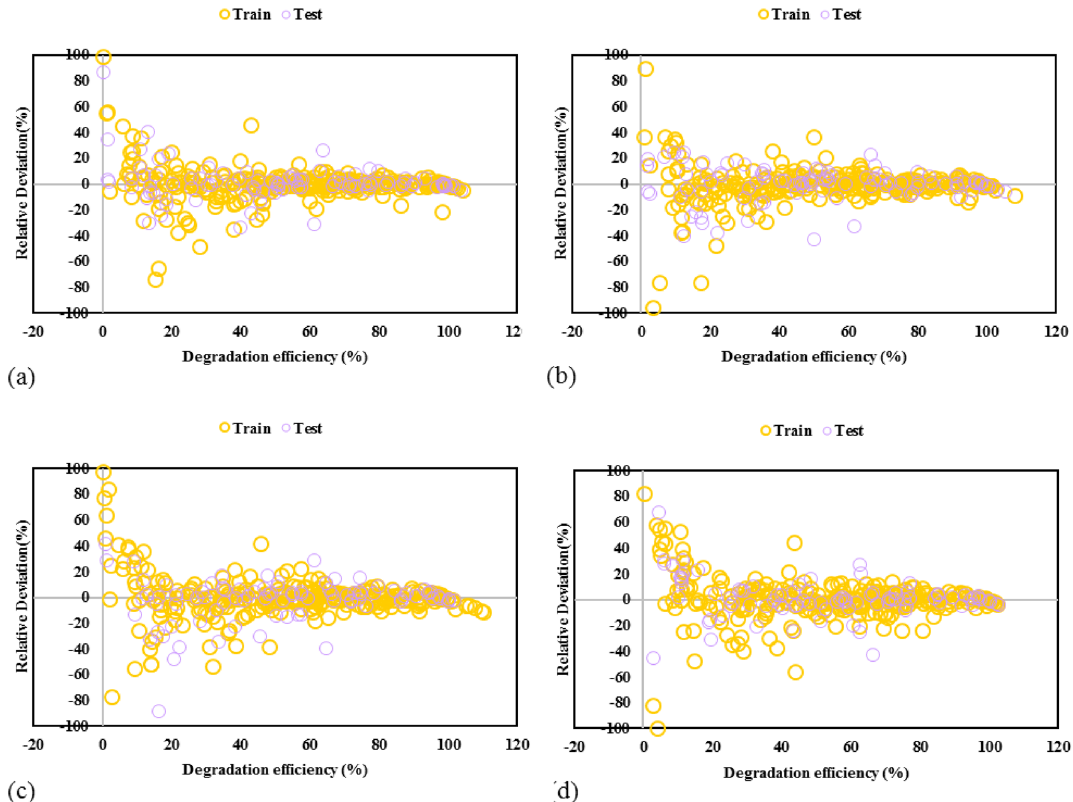
Figure 5. Comparison of actual and model predicted values for GPR model containing kernel function of (a) matern, (b) exponential, (c) squared exponential, (d) rational